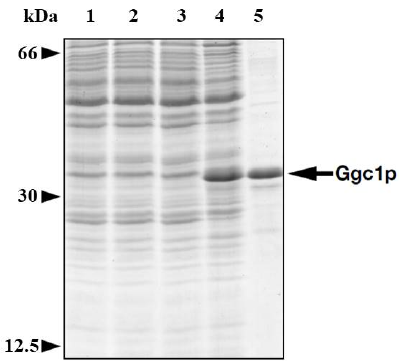
Figure 1. Bacterial overexpression and purification of Ggc1p. Proteins were separated by SDS–PAGE and stained with Coomassie blue dye. Markers: 66 kDa, bovine serum albumin; 30 kDa, carbonic anhydrase; 12.5 kDa cytochrome c; lanes 1–4, Escherichia coli BL21(DE3) containing the vector with the coding sequence of GGC1 (lanes 2 and 4), or the empty vector (lanes 1 and 3). Lane 5, purified Ggc1p (4 µ g) originating from bacteria shown in lane 4. Samples were taken at the time of induction (lanes 1 and 2) and 5 h later (lanes 3 and 4). The same number of bacterial cells was analyzed in each sample (30 µ g of cellular